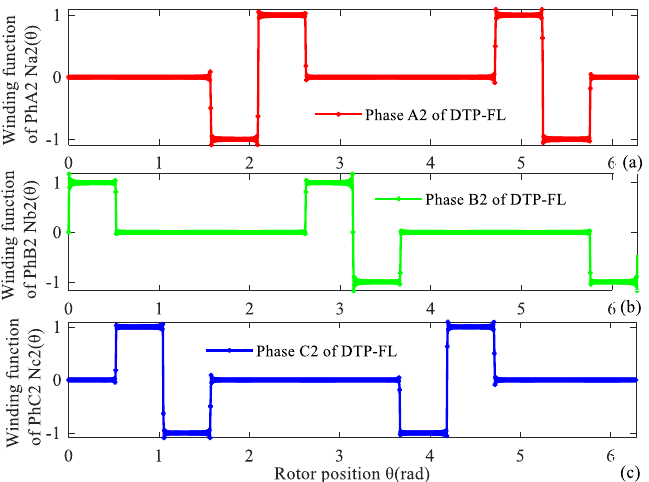
Figure 12. Winding function of second group of DTP-FL winding. ( a ) A2, ( b ) B2, ( c ) C2.